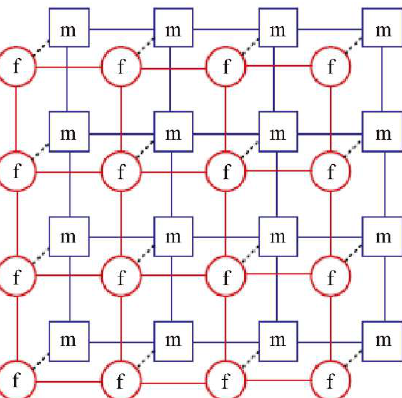
Figure 3. Schematic illustration of dual permeability model [22]. Reproduced from [22], Zeng: 2015. Cipolla et al. [26] proposed a workflow that combined microseismic data with dynamic simulations. By constructing 3D hydraulic fracture networks as a series of very fine grids and implementing the networks with a reservoir simulation model, the authors demonstrated that fluid flow analysis enhances accuracy.